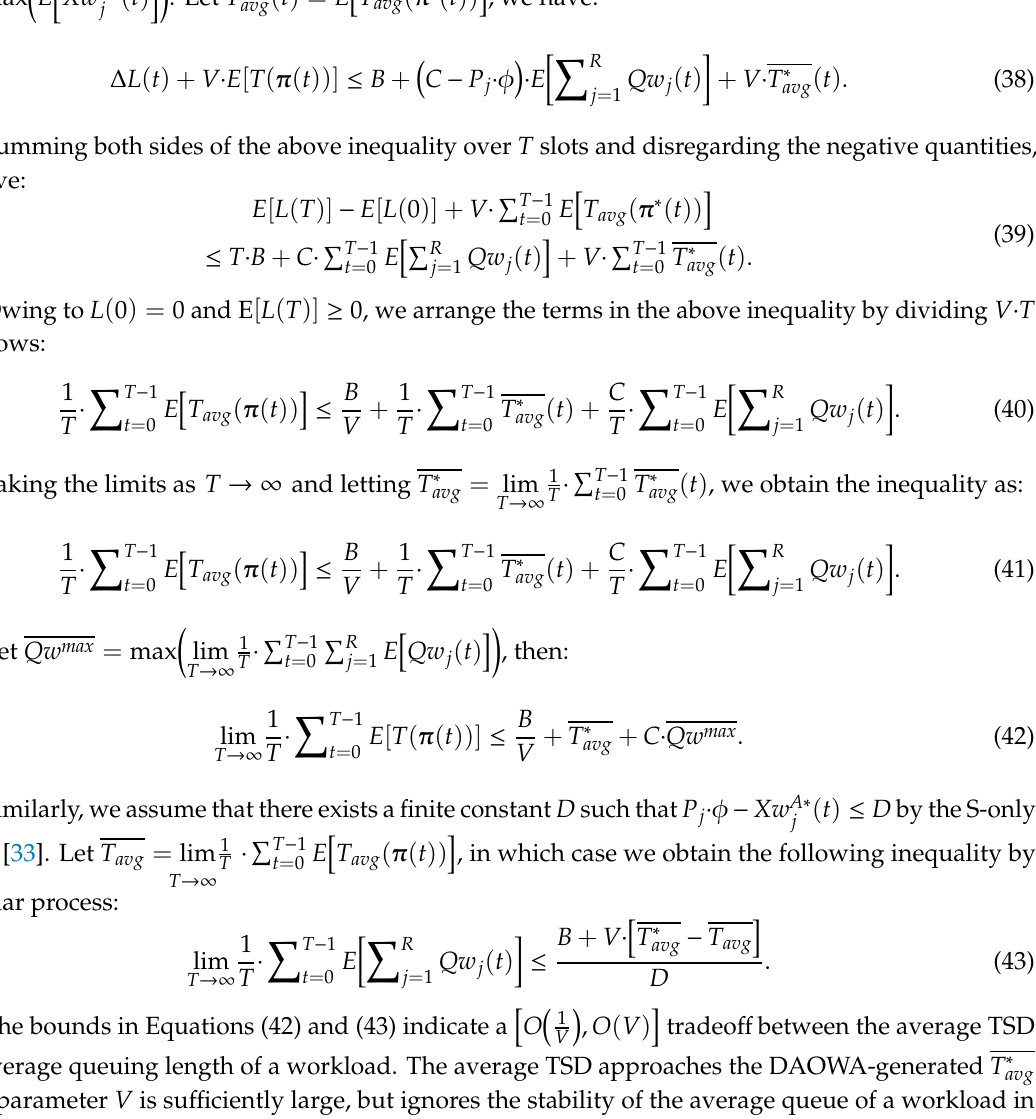
(cid:104) (cid:105) λ ( t ) , λ ( t ) , λ ( t ) 2 3 1 (cid:104) (cid:105) l 1 ( t ) , l 2 ( t ) , l 3 ( t ) .